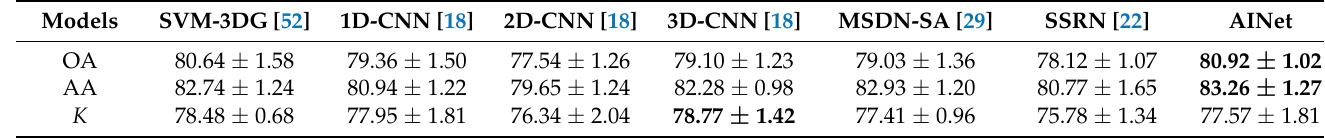
Table 11. Classification results with spatially disjoint samples for the KSC